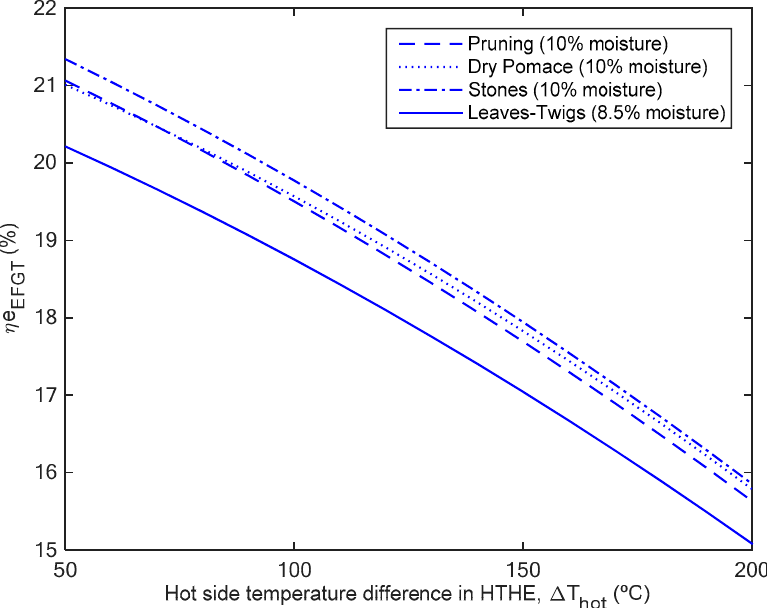
Figure 6. Influence of the hot side temperature difference of the HTHE ( ∆ T hot ) in the η e different biomasses proposed.